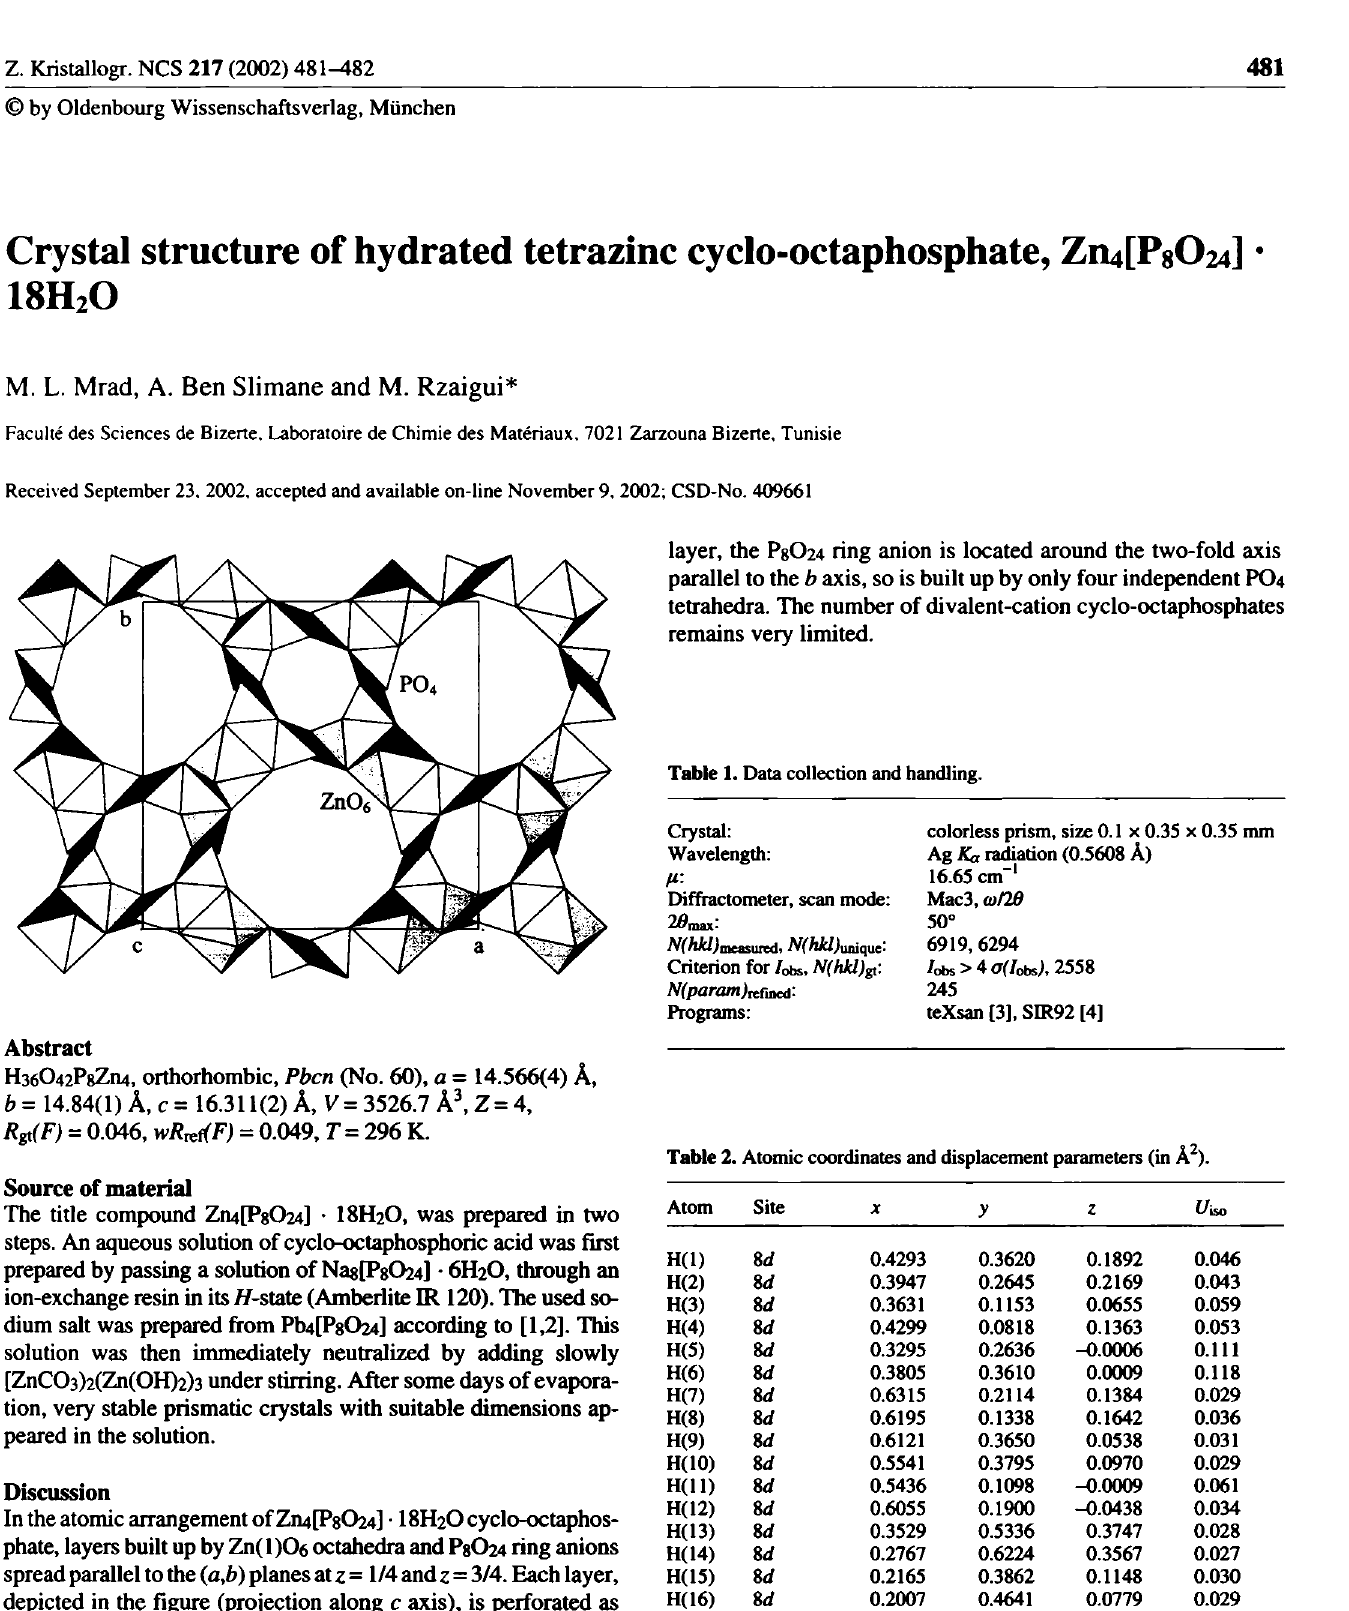
Table 2. Atomic coordinates and displacement parameters (in Â 2